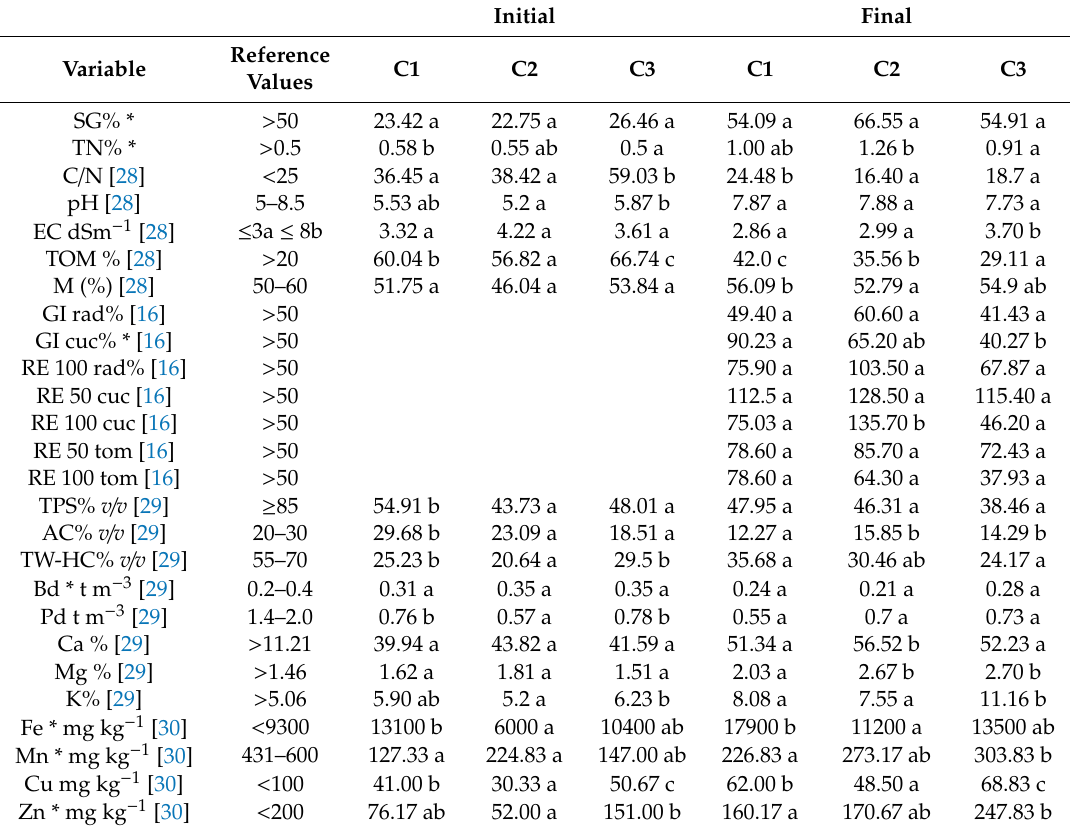
Table 2. Initial and final means of the analysis of variables measured in the mixtures: C1, C2 and C3 obtain of ANOVA and Bonferroni